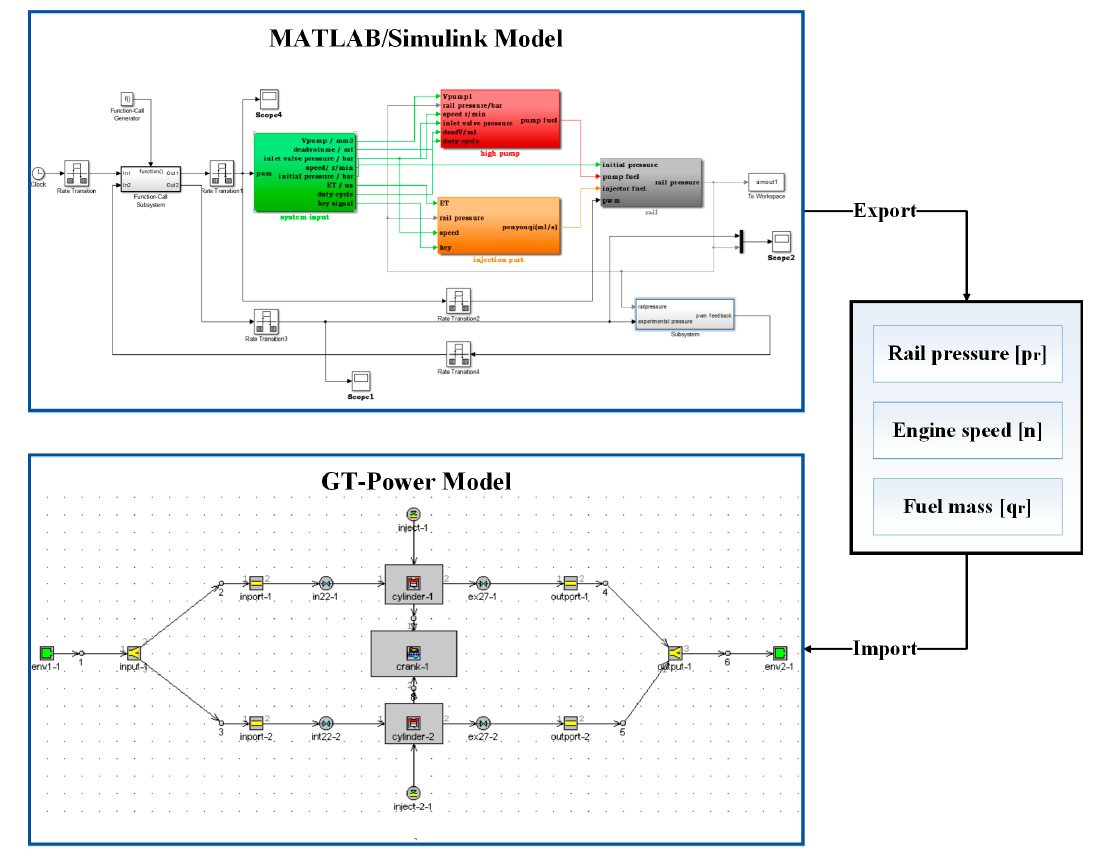
Figure 10. Co-simulation of OP2S engine using MATLAB/Simulink & GT-Power.